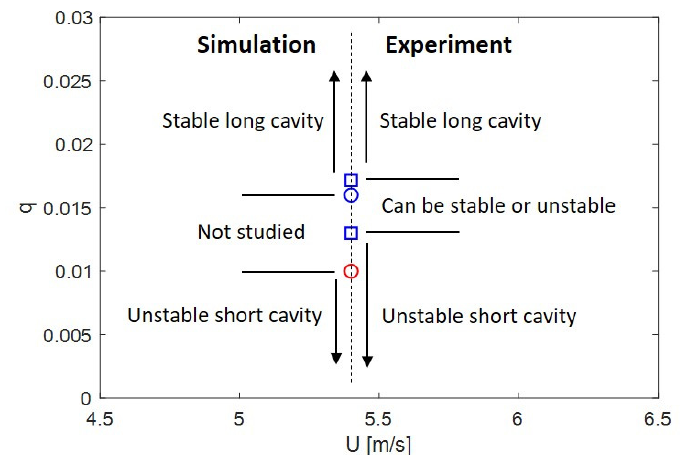
Figure 9. Air cavity regimes near water speed 5.4 m/s. Blue squares, experimentally obtained minimum air flow rates required to maintain stable long air cavity. Blue circle, numerically used air flow rate when stable long air cavity was present (as in Figure 5a). Red circle, numerically used air flow rate when air cavity collapsed to short state (as in Figure 7b).